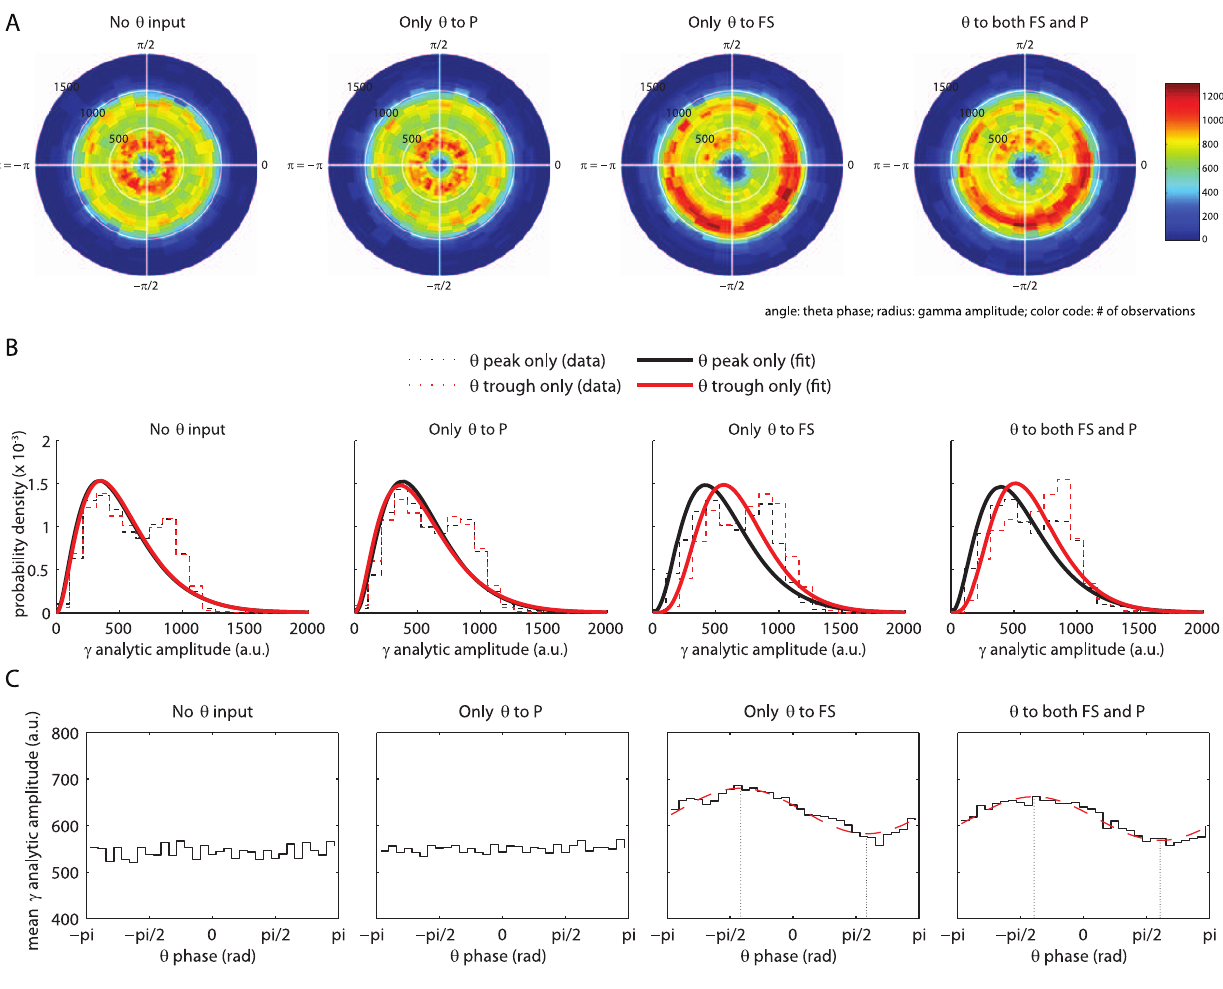
Figure 7. Effect of theta-modulated input on LFP gamma amplitude. (A) The distribution of a composite theta phase/gamma amplitude signal z ( t ) in the complex plane. Color code represents the number of observations; angle corresponds to theta phase (divided into 32 equally-sized 2 p wide phase bins); radius corresponds to gamma amplitude (divided into 32 equally-sized bins). (B) Histograms of gamma amplitudes occurring in 32 p p ; black) and at the trough ( Q h ~{ ; red). Dashed lines correspond to the observed data bins centered at the peak of the theta rhythm ( Q h ~ 2 2 histograms; solid lines represent the best-fit gamma distribution for this data. When FS cells receive theta-modulated input, the best-fit distribution for the theta trough is shifted to the right, compared to the distribution for the theta peak (parameter differences are significant, p v 0 : 0001 ). (C) Mean gamma amplitude as a function of theta phase. For the two rightmost plots, the best-fit sine functions are shown by a dashed red line. Gamma amplitudes are higher at the trough than at the peak of the theta rhythm, and the lowest and highest gamma amplitudes (indicated by dotted vertical lines) occur somewhat after the theta peak and trough, respectively.